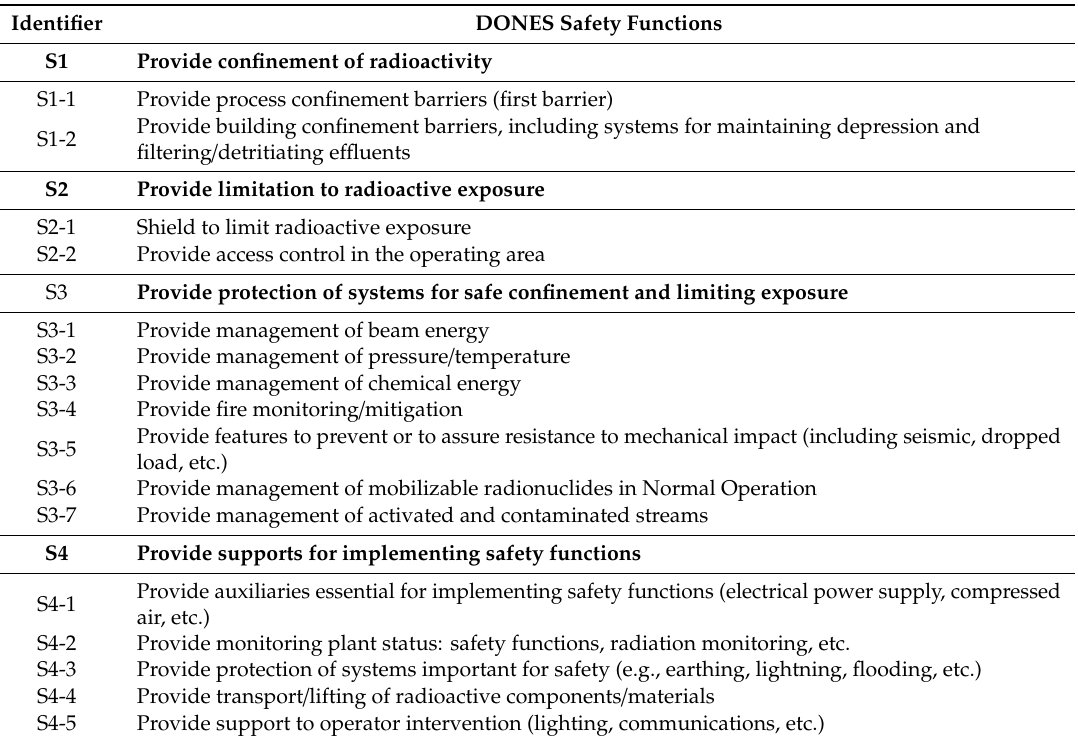
Table 4. Main DONES Safety Functions and